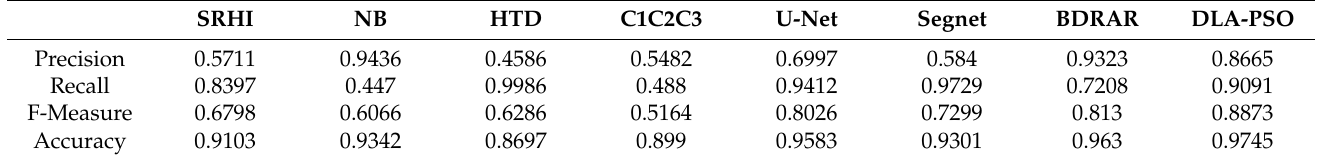
Table 9. Evaluation index for vegetation shadow in San Francisco